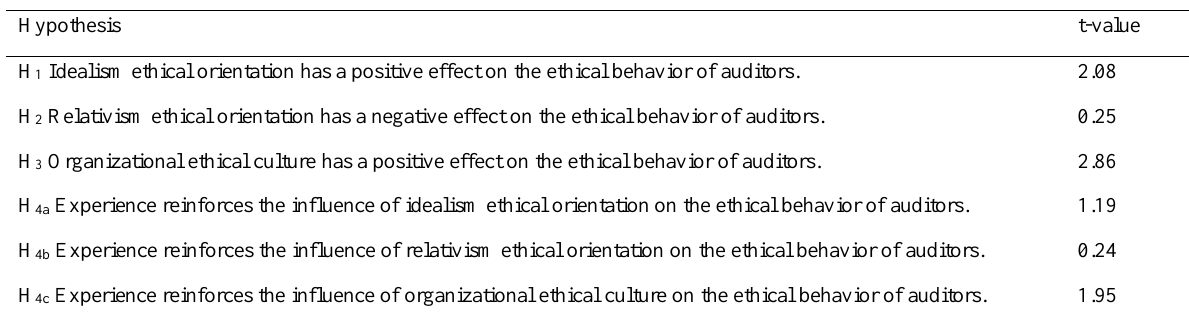
Table 4: Results of Hypothesis